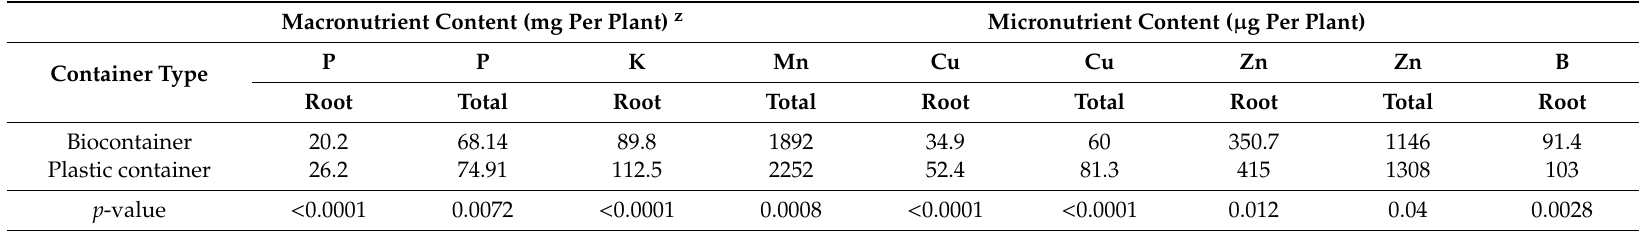
Table 2. Container type a ff ects contents of macro- and micro-nutrients in roots, or total in the plant of H. macrophylla ‘Merritt’s